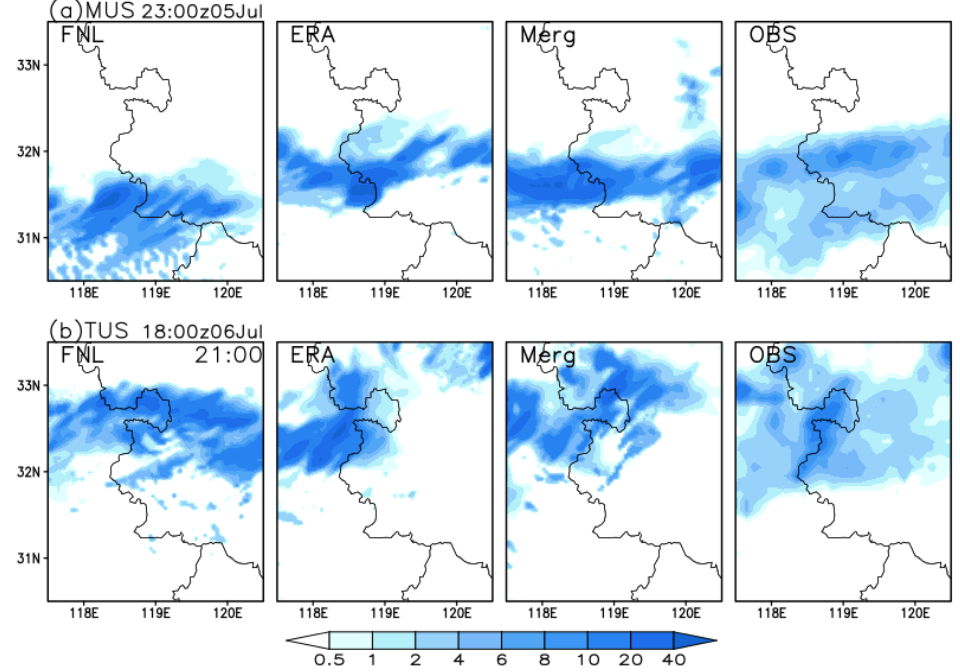
Figure 8. Comparison of the strongest precipitation (units: mm) of the three simulated MCSs and observed MCSs. ( a ) Shows the MUS on 5 July and ( b ) shows the TUS on 6 July.